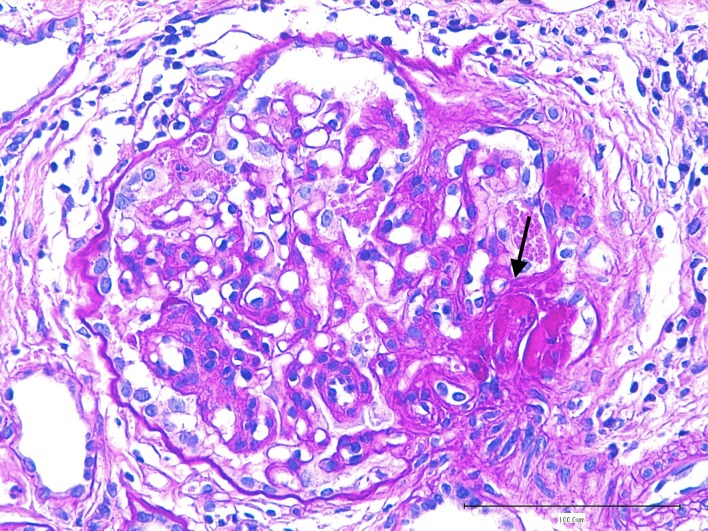
Glomerulus from the azotemic Dogue de Bordeaux dog.Global consolidation of capillary lumens by extracellular matrix, synechiae and deposition of hyaline material (arrow) are visible. Parietal epithelium and podocytes are hypertrophied. Periodic acid—Schiff staining (400x).